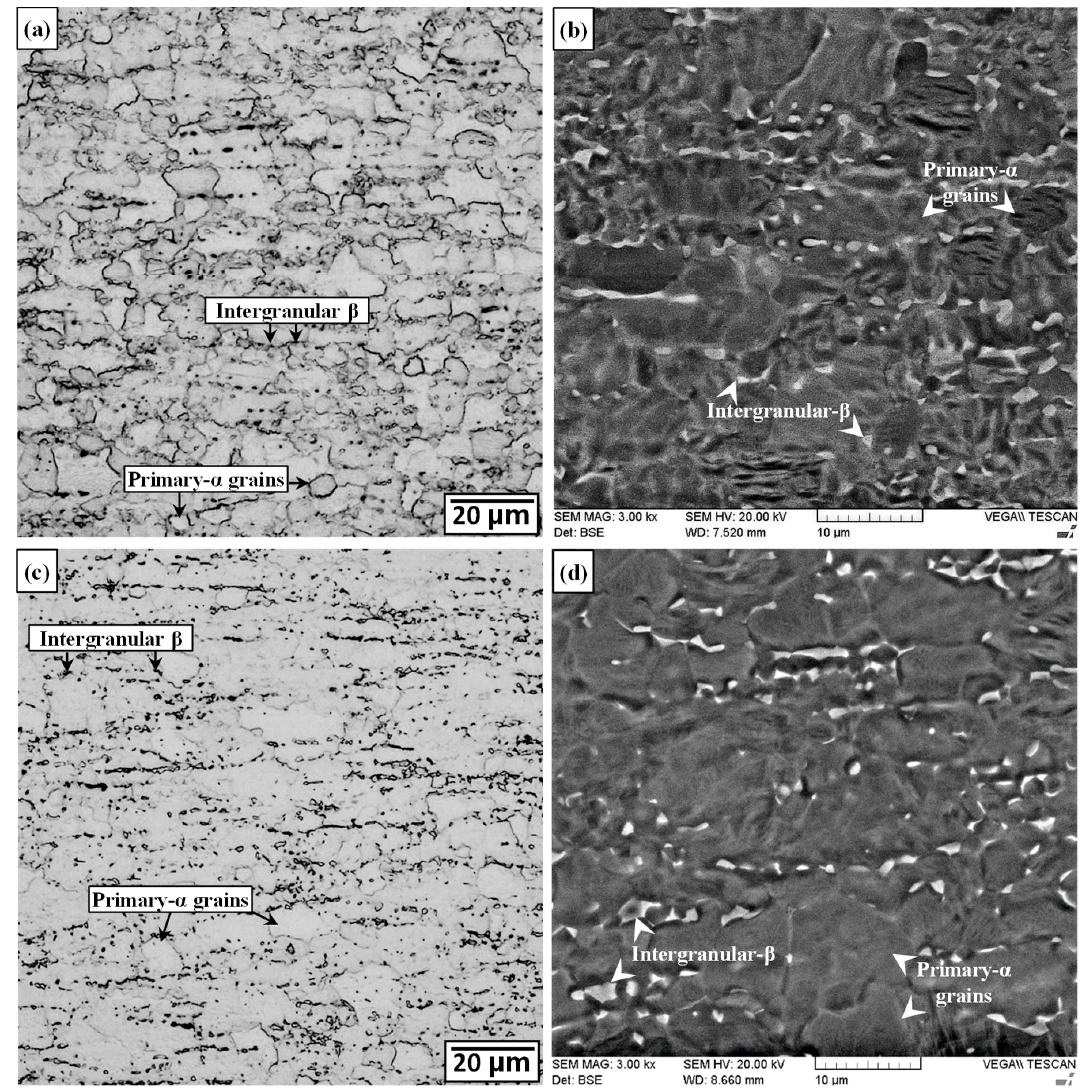
Figure 6. Microstructure of Ti-64 PM ( a , b ) as-received (OM and SEM) ( c , d ) SRAed (OM and SEM).